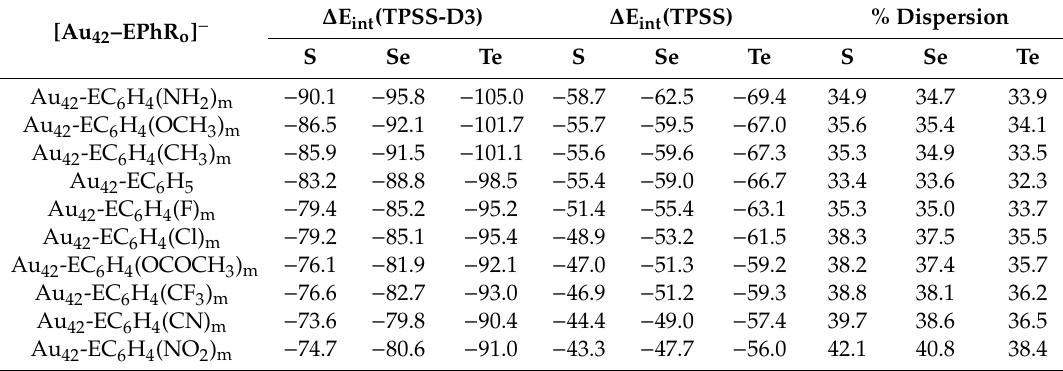
Table 2. Interaction energies between Au 42 and meta substituted chalcogen (E = S, Se, Te). Energies listed correspond to the total interaction energies ( ∆ E int (TPSS-D3)) and without the dispersion contribution ( ∆ E int (TPSS)). Percentage of dispersion term is included. All energies are in kcal / mol. ∆ E ∆ E int (TPSS-D3) int (TPSS) [Au 42 –EPhR o ] − Se Te Te